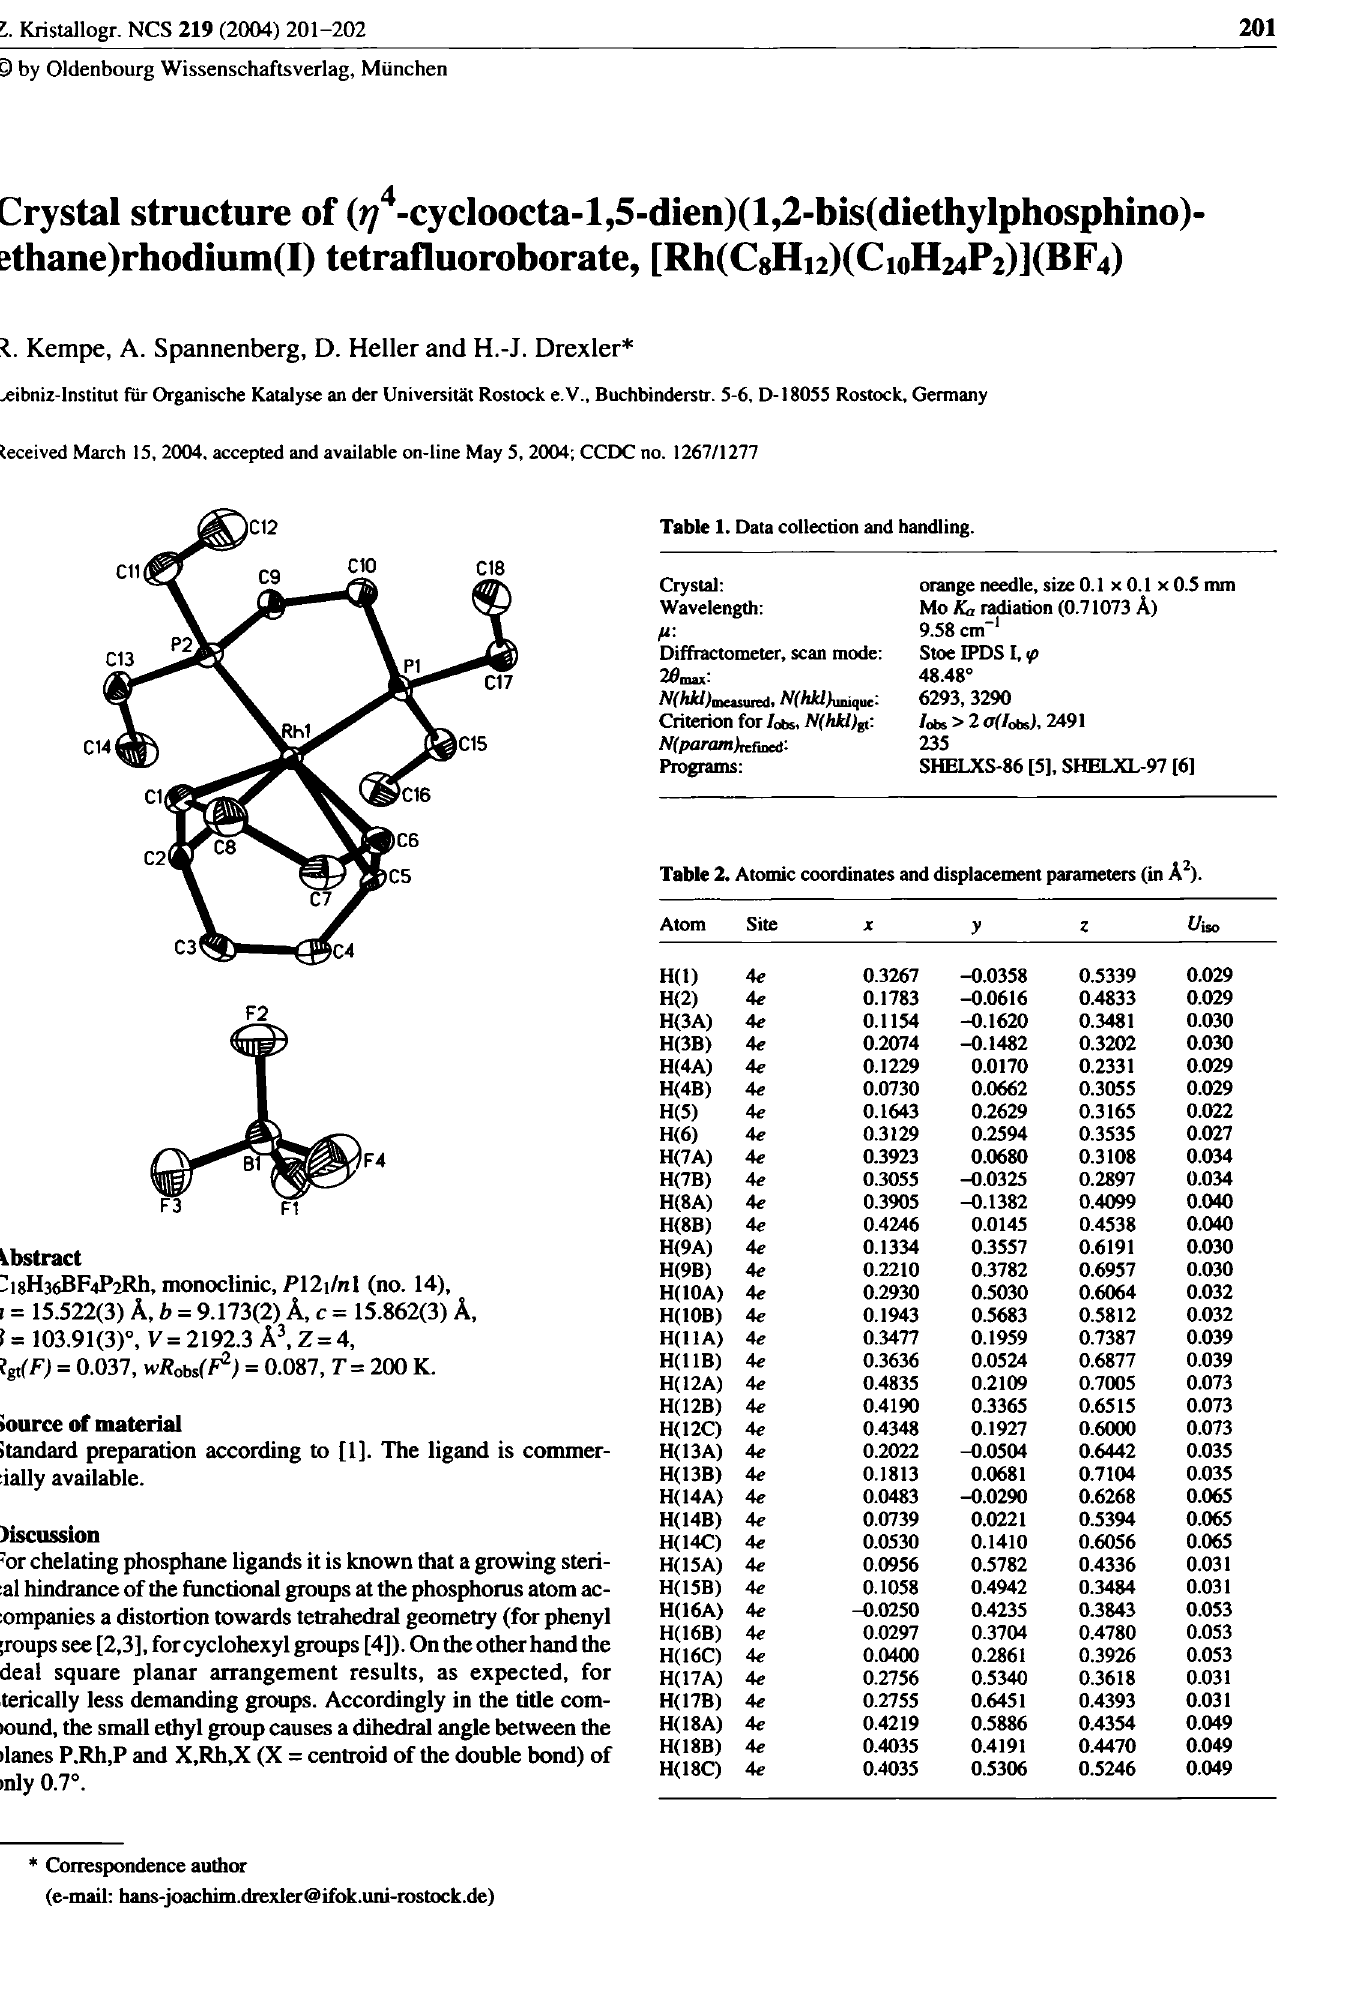
Table 2. Atomic coordinates and displacement parameters (in Â 2